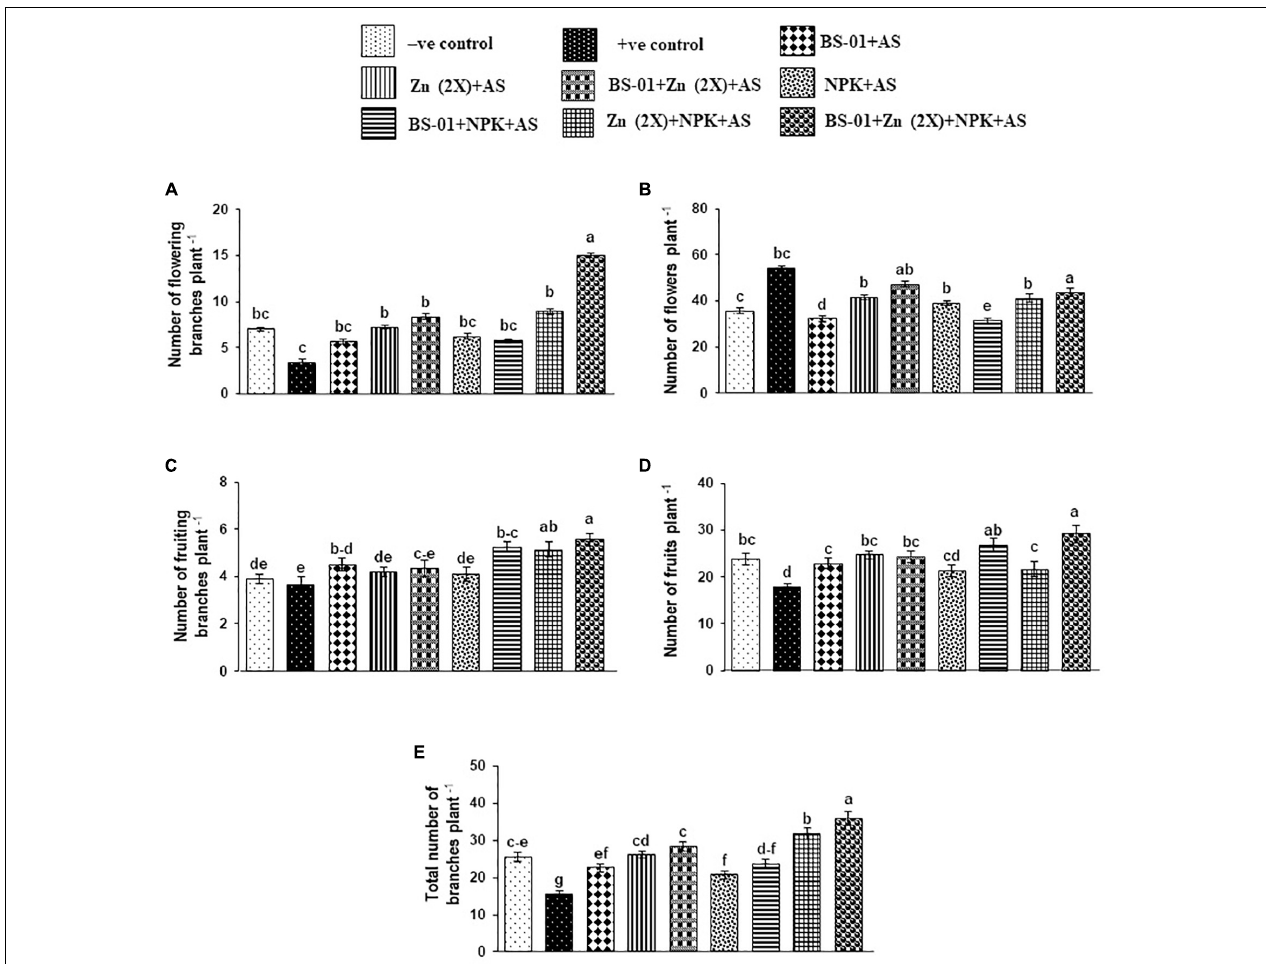
FIGURE 3 | (A–E) Effect of Bacillus subtilis (BS-01) and mineral nutrients [Zn (2X: 10 kg acre − 1 ) and NPK (64:46:50 kg acre − 1 )] on the number of flowering branches (A) , number of flowers (B) , number of fruiting branches (C) , number of fruits (D) , and the total number of branches (E) of tomato plants inoculated with Alternaria solani (AS) in the field after 30 days of pathogen inoculation (DPI). Values with different letters show a significant difference ( p ≤ 0.05) in the mean value of replicates as determined by the LSD test. Error bars indicate standard errors of the mean of replicates. − ve control, without inoculation of AS and nutrient application; +ve control, with inoculation of AS only (foliar